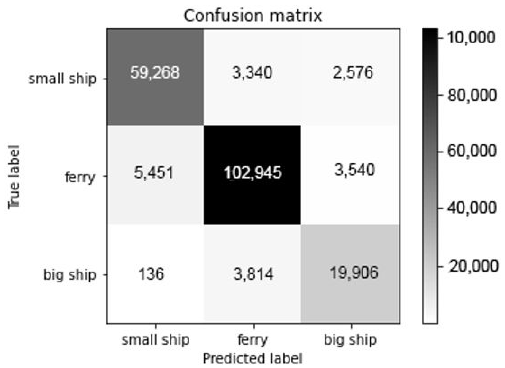
Figure 9. The confusion matrix of the proposed model obtained from testing data.